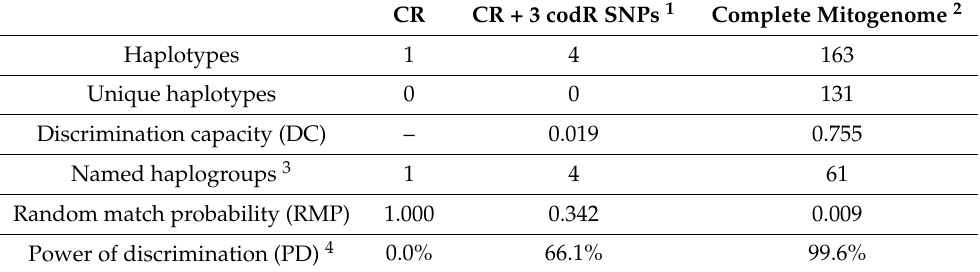
Table 1. Diversity parameters of the 216 Italian mtDNAs exhibiting the most common West Eurasian control region (CR) haplotype using different sequence ranges. Percentages are rounded (see text for details). CR CR + 3 codR SNPs